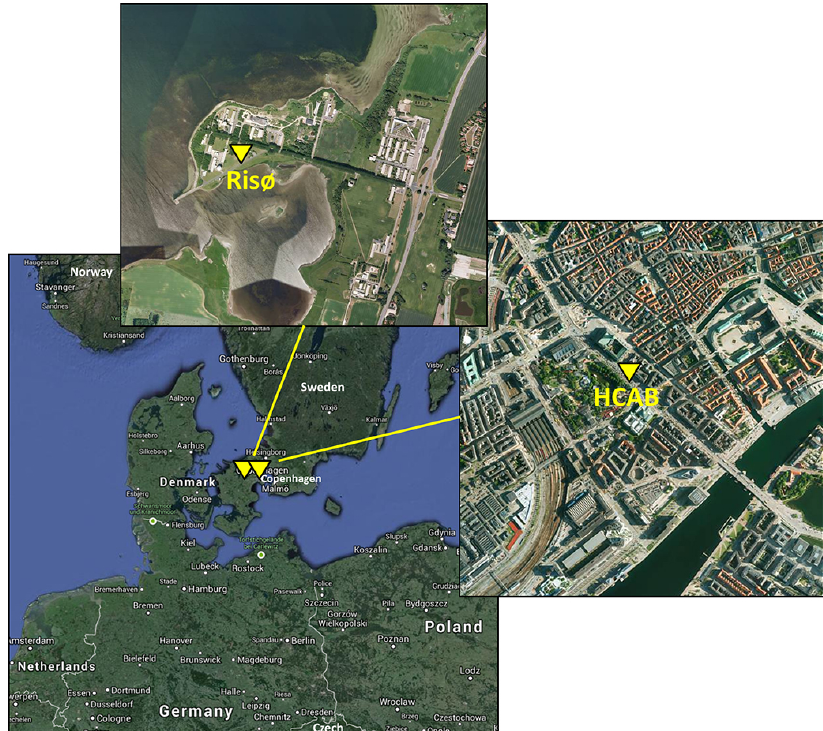
Figure 1. Locations of the urban curbside station H.C. Andersens Boulevard (HCAB) and the semi-rural background station (Risø) (map. krak.dk and map.google.dk). HCAB is located in the city center of Copenhagen close to a busy street. Risø is located approximately 30km west of